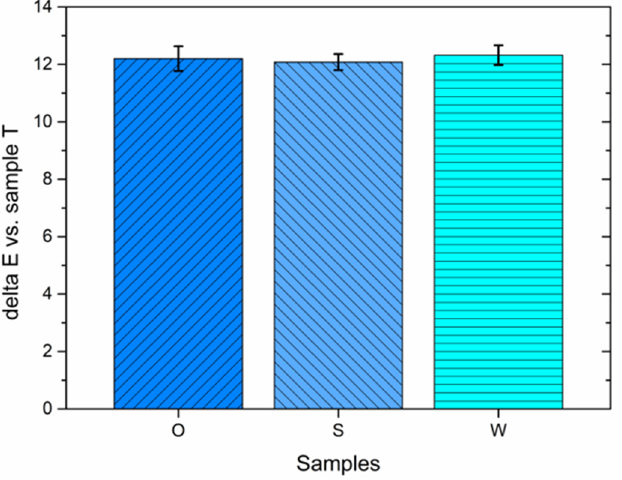
Figure 4. Change in appearance of the samples due to the contribution of the bio-based granules.